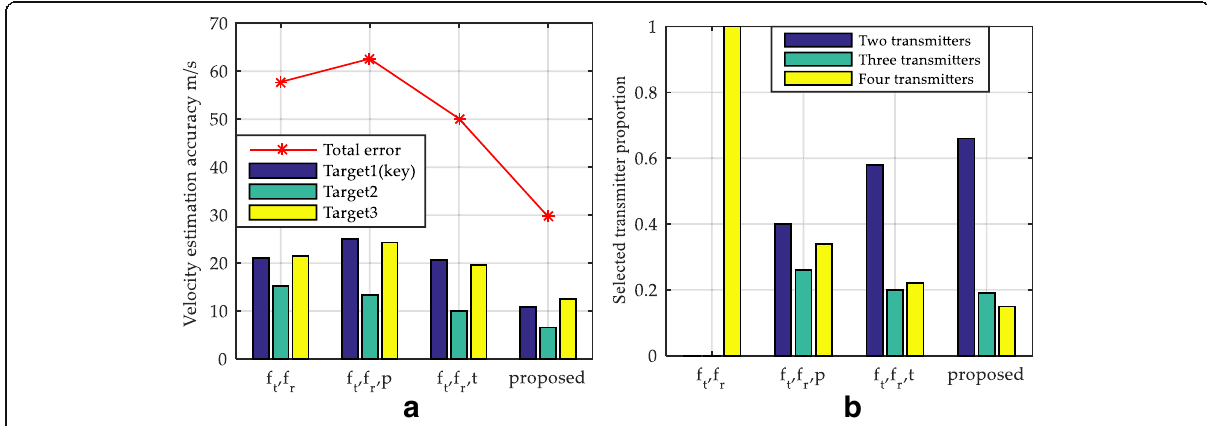
Fig. 6 Velocity estimation accuracy and transmitter number at random layout MSE = [inf, 10 2 , inf]m 2 /s 2 . a Velocity estimation accuracy b Transmitter proportion